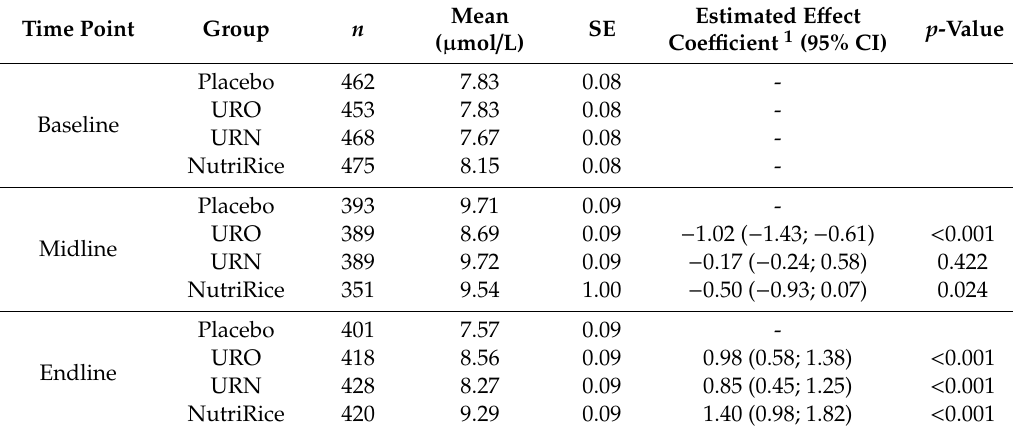
Table 4. Biochemical outcomes of serum zinc concentration of participating children after three and six months of